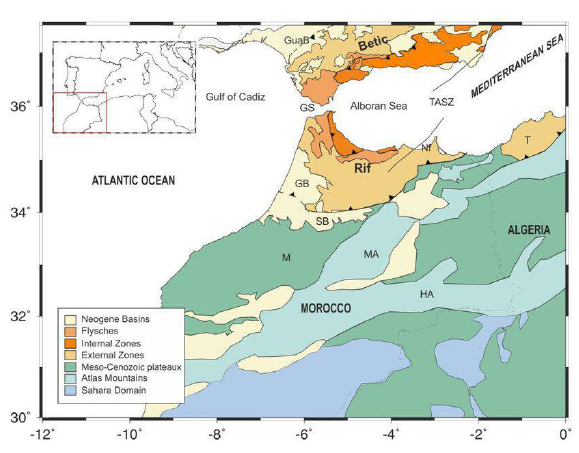
Fig. 1 - Simplified geological map of northern Morocco and southern Spain. The Atals Mountain is identified between the major domains. GB: Gharb Basin; GS: Gibraltar Strait;